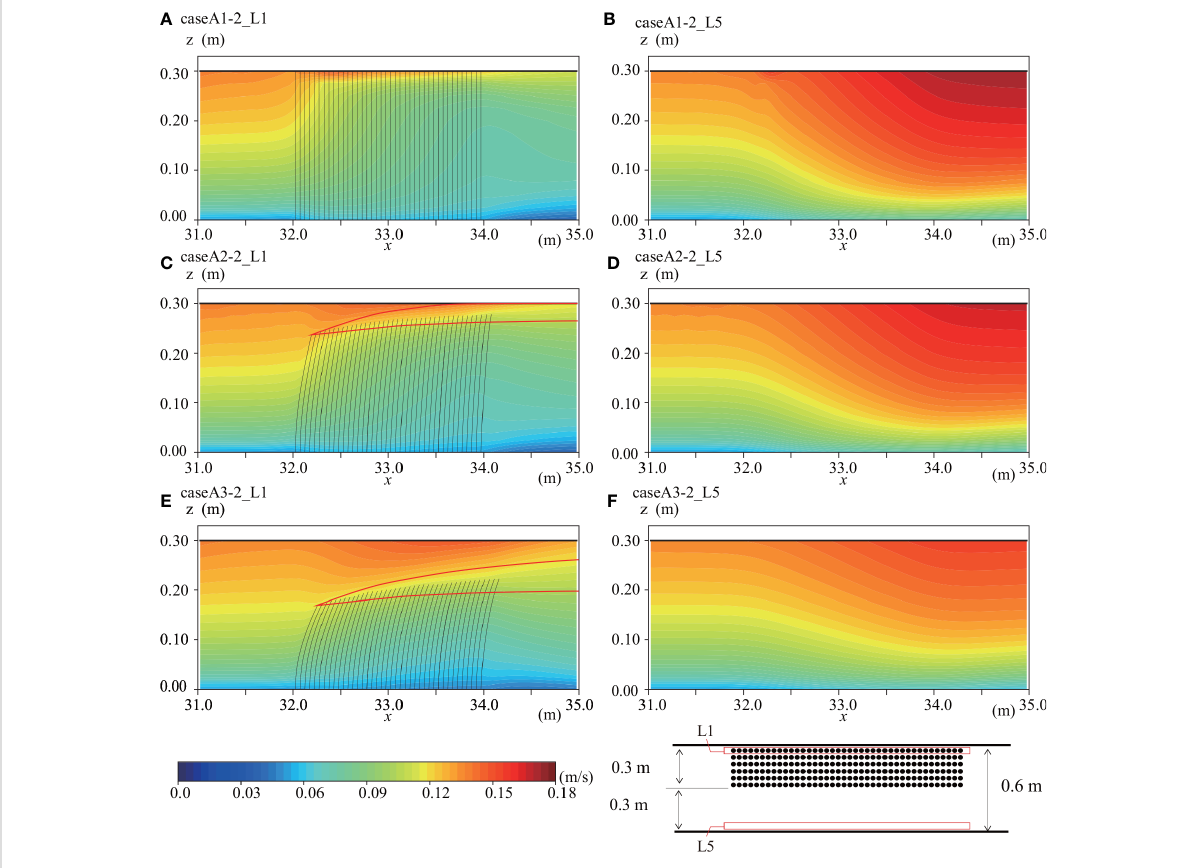
FIGURE 7 Horizontal velocity distributions at (A) L1 in case A1-2, (B) L5 in case A1-2, (C) L1 in case A2-2, (D) L5 in case A2-2, (E) L1 in case A3-2, and (F) L5 in case A3-2.